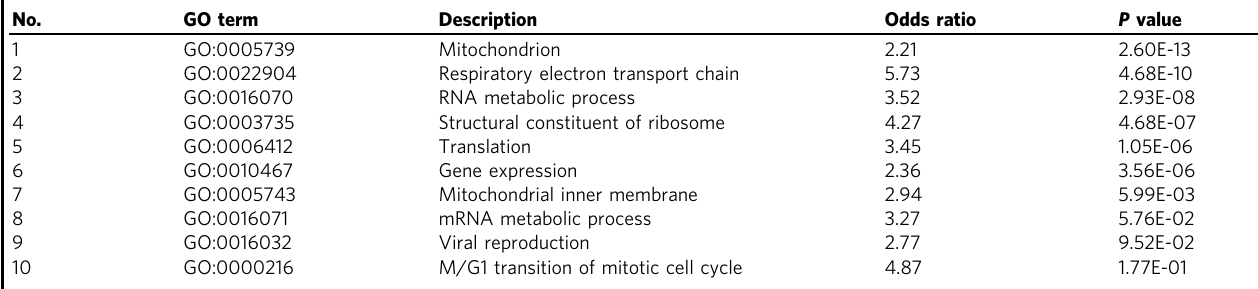
Gene Ontology terms (Biological Processes) were used for the analysis. The most enriched clusters were related to mitochondria and protein synthesis.